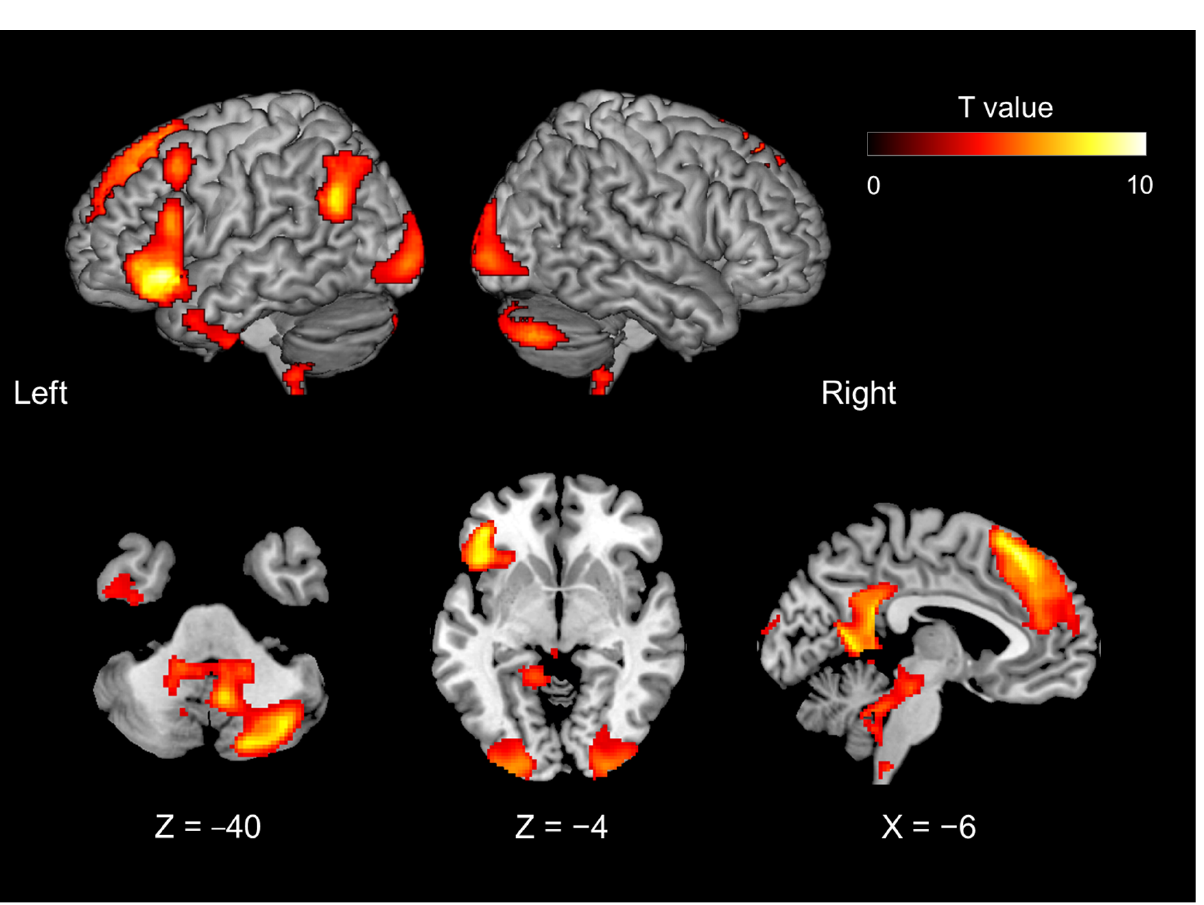
Figure 3. Brain activity during the disclosure phase of introspection relative to object feature iden- tification, irrespective of mismatch and match conditions (Contrast #11, Table 1) (cyan region); and